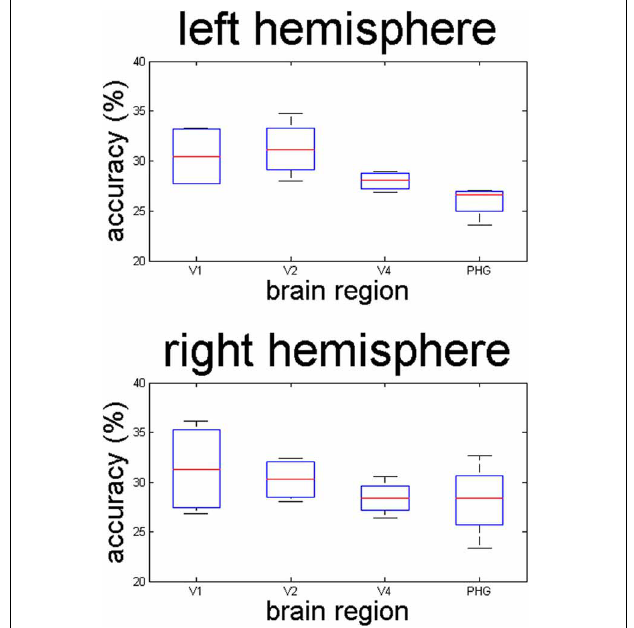
FIGURE 2 | The linear classifier’s prediction accuracies for the presented material categories, based on voxel activations in V1, V2, V4, and the parahippocampal place area. Results for the left hemisphere are shown on top; the results for the right hemisphere at the bottom. Error bars indicate the standard error of the mean, across subjects. Chance performance is 25% accuracy.